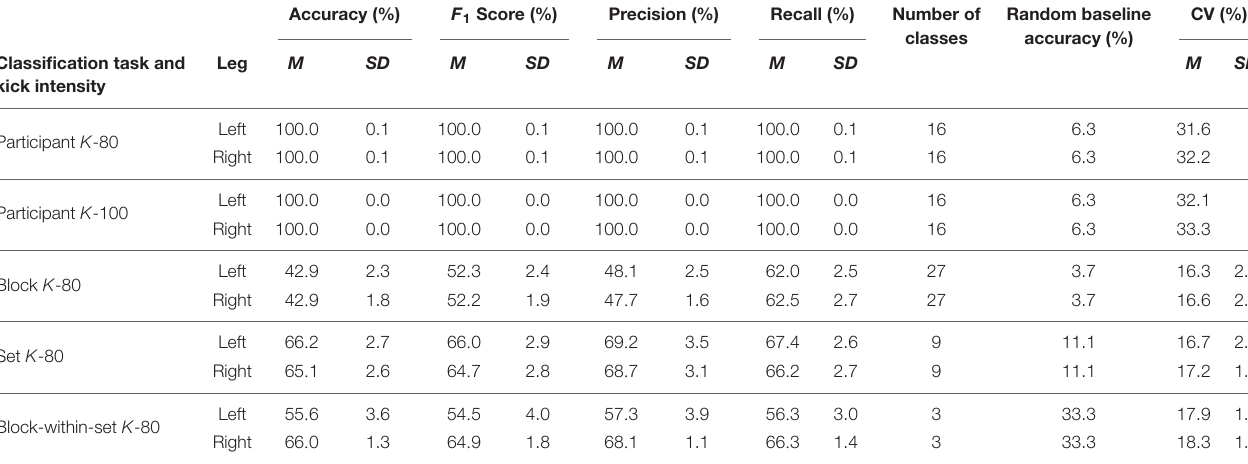
Random baseline CV (%) classes accuracy (%)